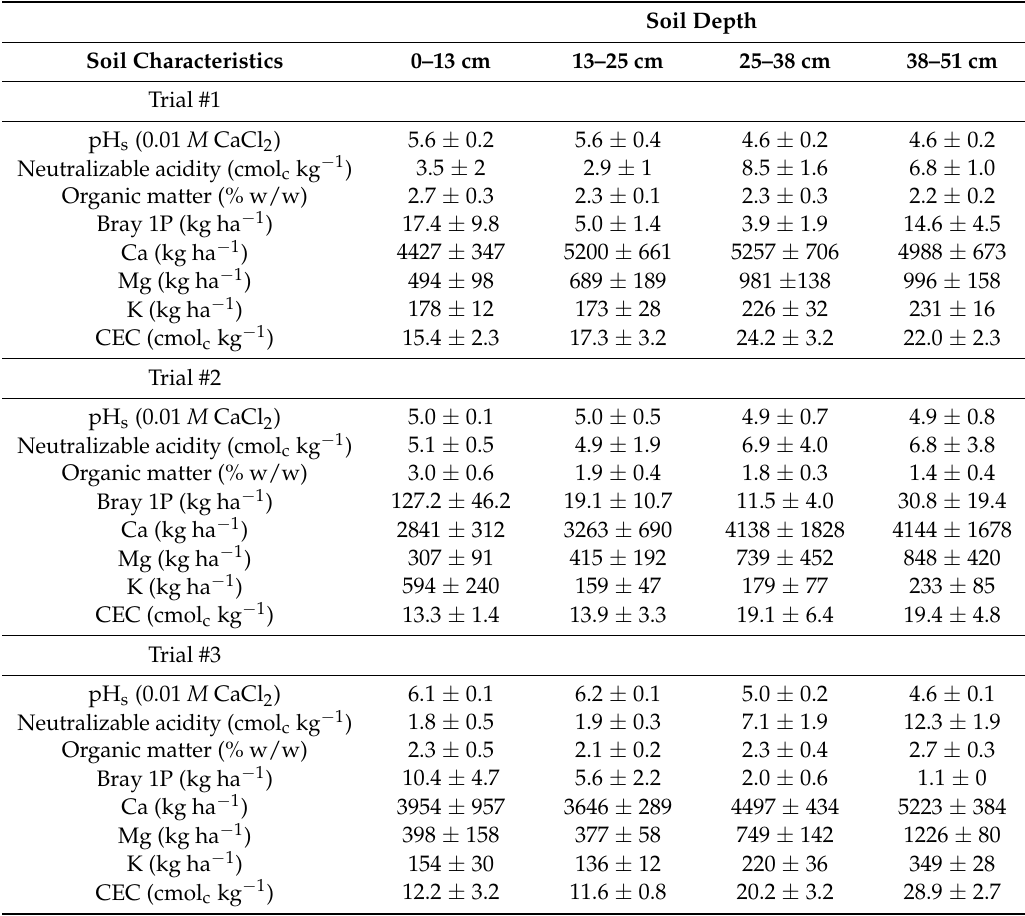
Table 1. Initial average soil characteristics ( ± standard deviation) at different depths for the Trial #1, #2 and #3 established in 2012, 2013, and 2014,